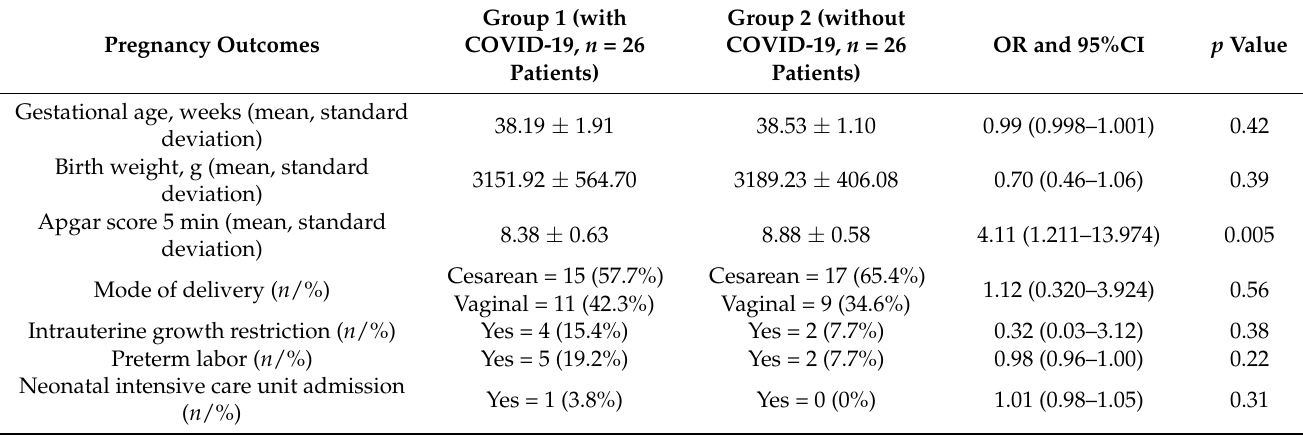
Table 4. Pregnancy outcomes for the two groups of patients included in the study.